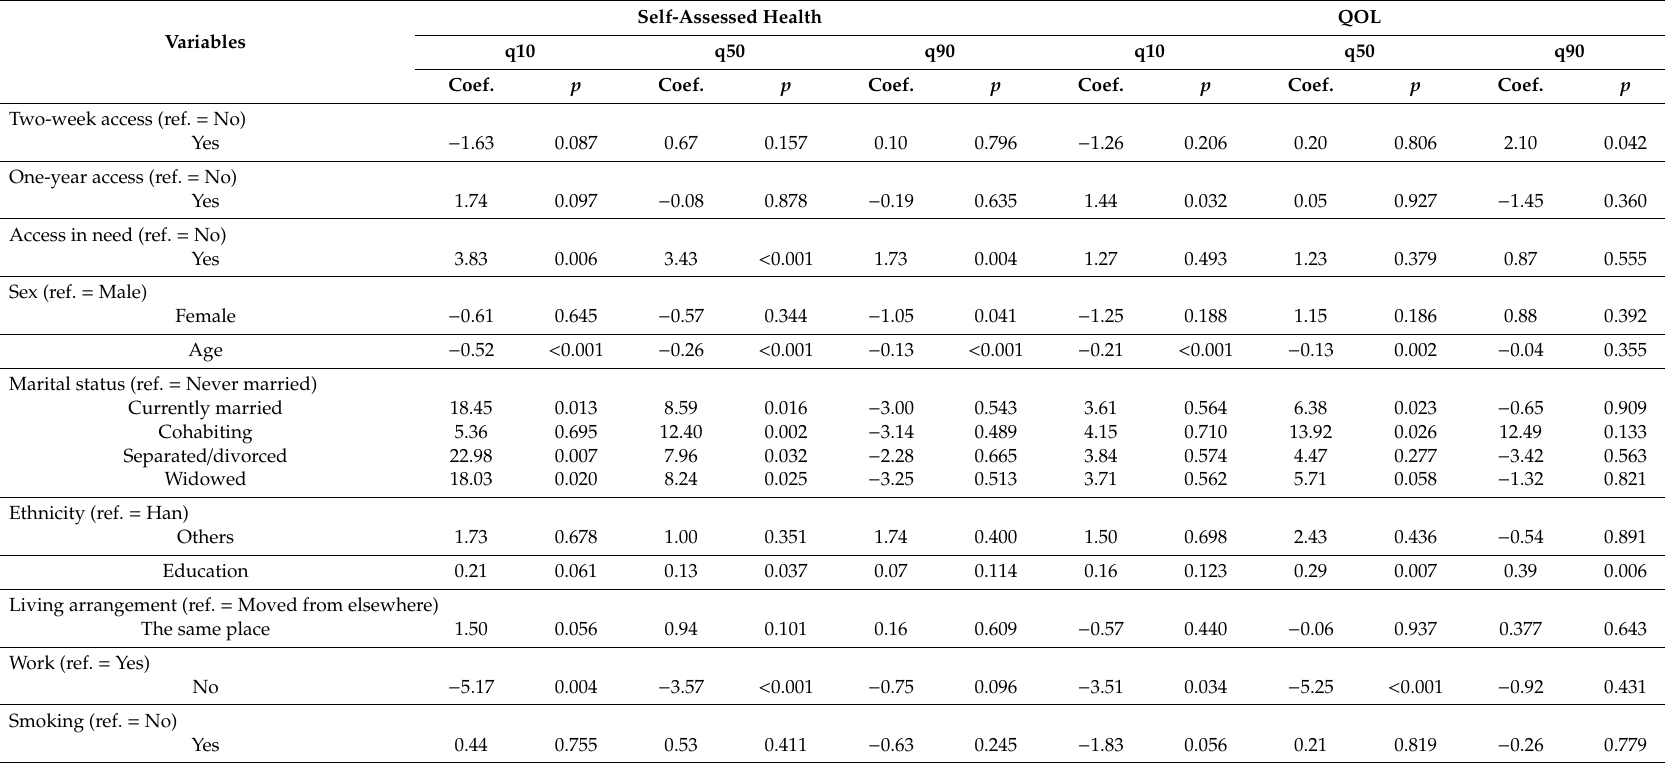
Table 3. Quantile regression results for self-assessed health and QOL using rural data ( n = 2602). Self-Assessed Health QOL Variables q10 q50 q90 q10 q50 q90 Coef. p Coef. p Coef.